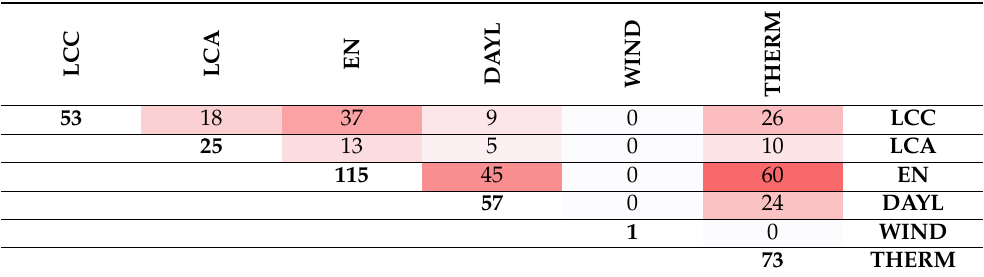
Table 1. The number of publications per each couple of objective functions. Color transparency is inversely proportional to the number of publications. The white color corresponds to zero, whereas the red color corresponds to the highest amount (60).